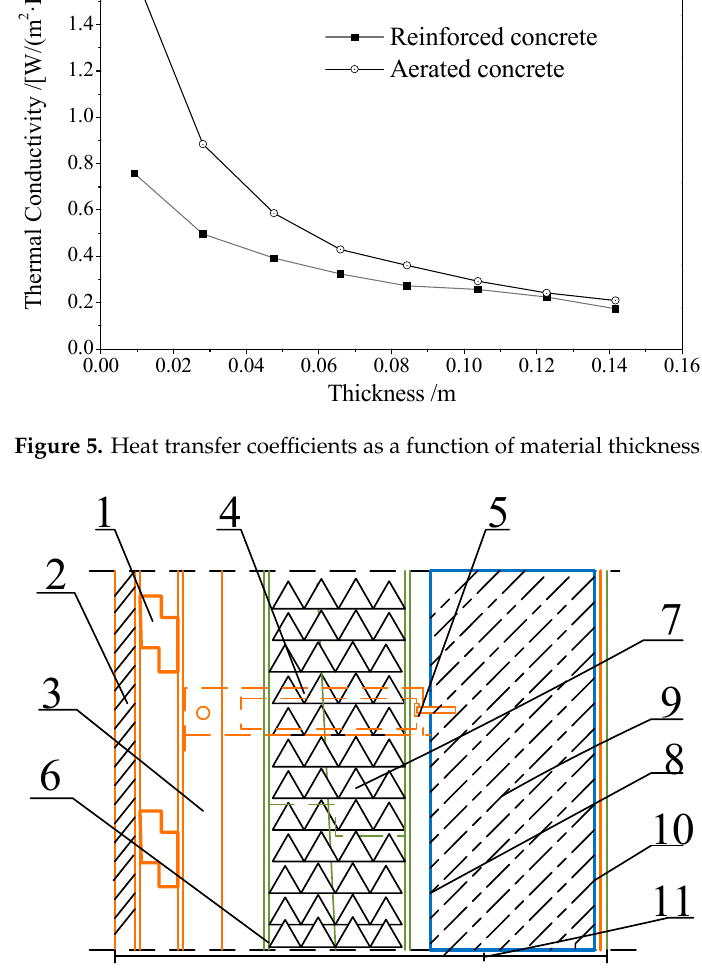
Figure 6. Schematic cross-section of external wall: (1) horizontal keel for external decoration board; (2) enhanced cement fibreboard; (3) vertical light steel keel for external decoration board; (4) thermal insulation anchorage; (5) special surface slurry; (6) composite alkali resistant glass fiber mesh cloth; (7) EPS staggered seam laying; (8) cement mortar flat layer; (9) lime mortar surface (seal layer); (10) reinforced concrete structure beam; (11) column network position axis.